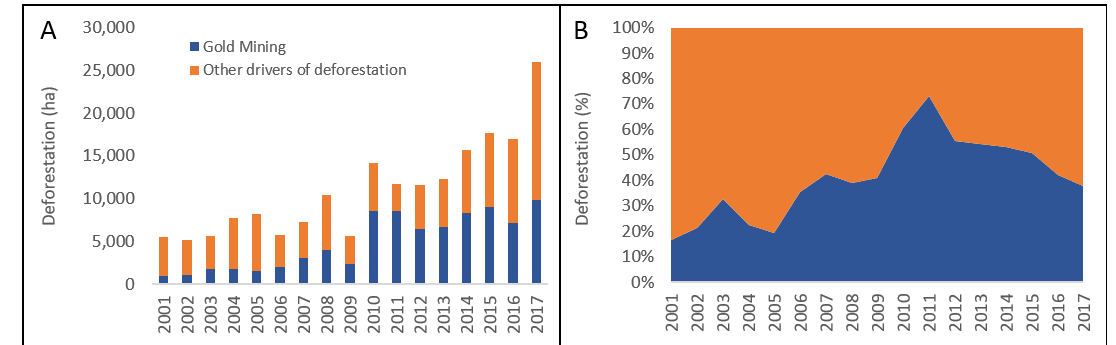
Figure 7. Deforestation due to mining compared to all other sources from 2001 through 2017. ( A ) Annual deforestation in hectares. ( B ) Deforestation by type as a percent of all deforestation with colors as in ( A ).